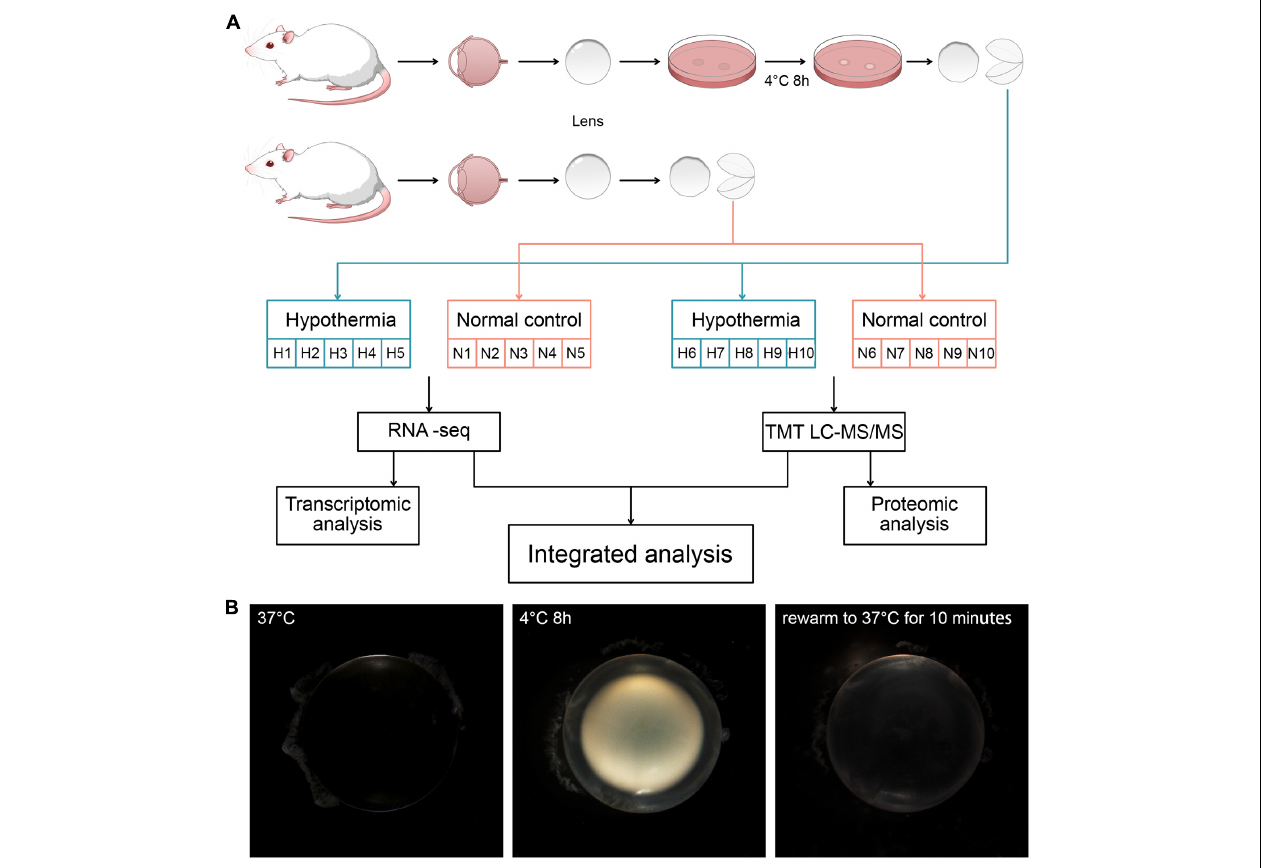
FIGURE 1 | (A) Grouping of the rats and treatments of their lens. Strategy for transcriptomic and proteomic analysis of the lens capsules in each group. (B) The morphological changes induced by hypothermia and rewarming treatments.